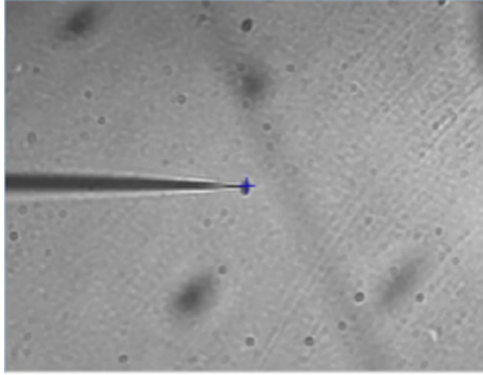
Figure 12. Single shot error test interface.